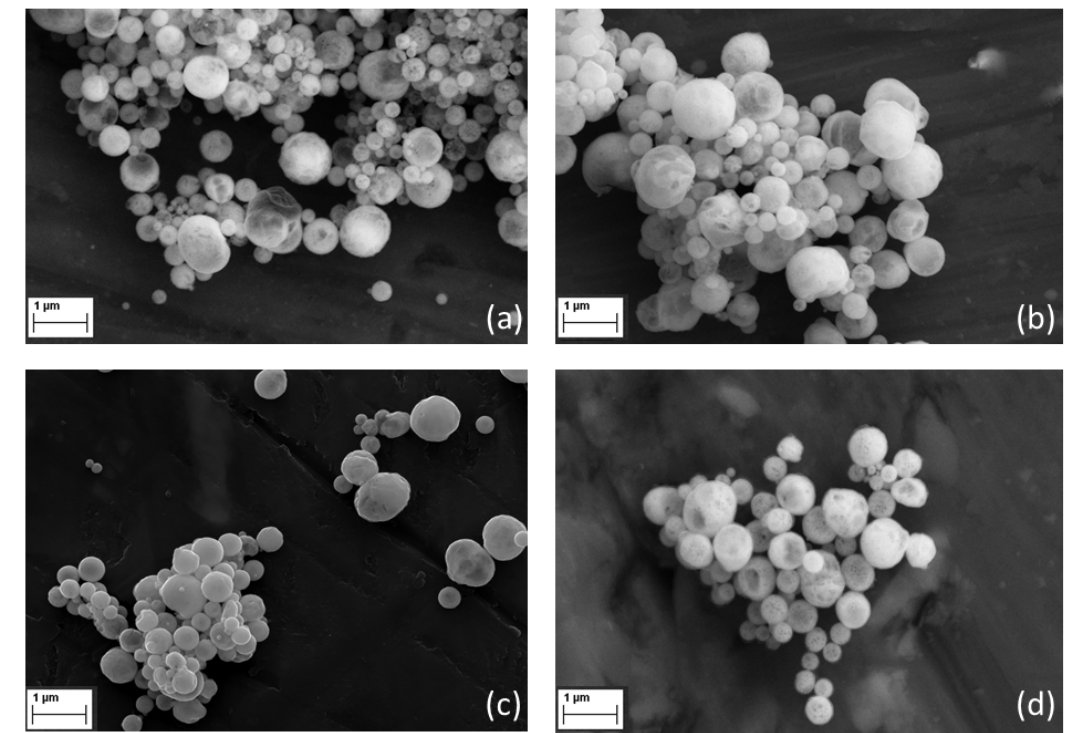
Figure 9. SEM analyses of mixed RE-Oxide powders synthesized with varying reaction temperatures ( a ) 700 °C; ( b ) 800 °C; ( c ) 900 °C; ( d ) 1000 °C.